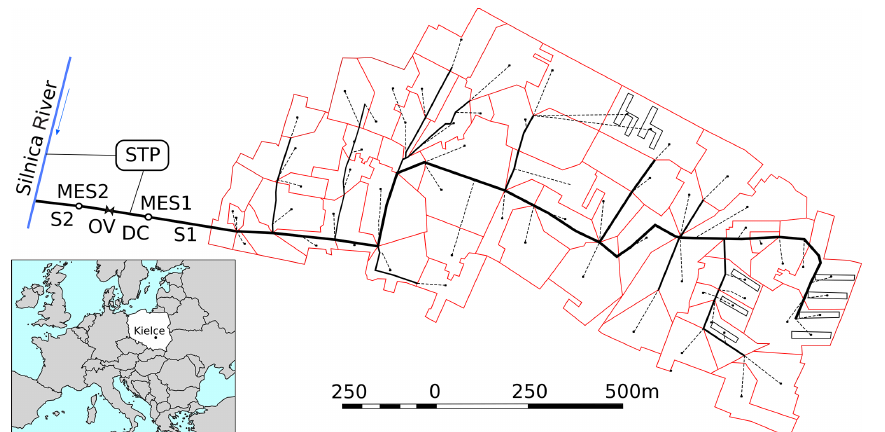
Figure 1. Diagram of the analyzed urban catchment.